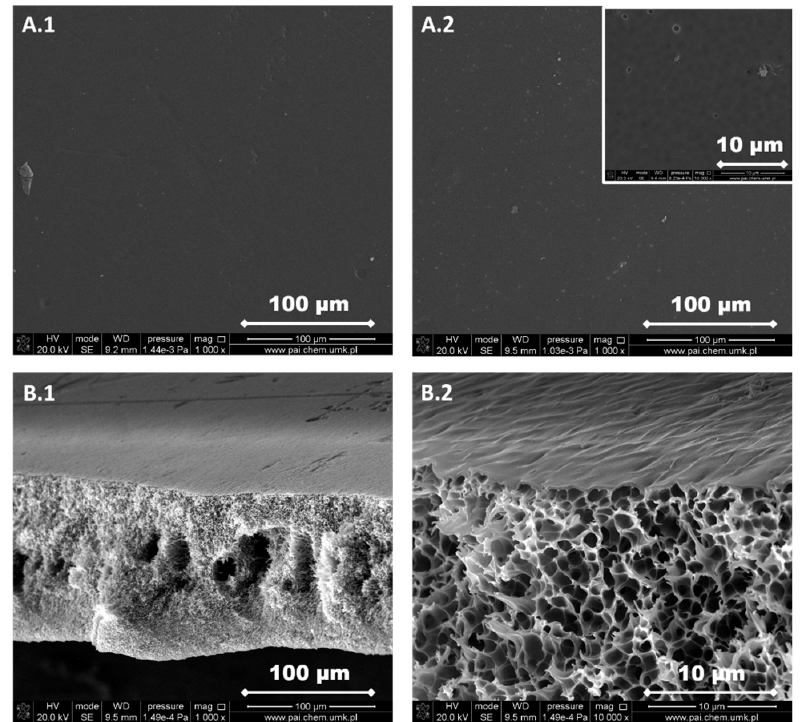
Figure 4. SEM images of M2 membrane. ( A.1 ) Selective layer, ( A.2 ) support layer, ( B.1 ) a cross-section of the membrane, and ( B.2 ) a cross-section of the membrane at higher magnification.